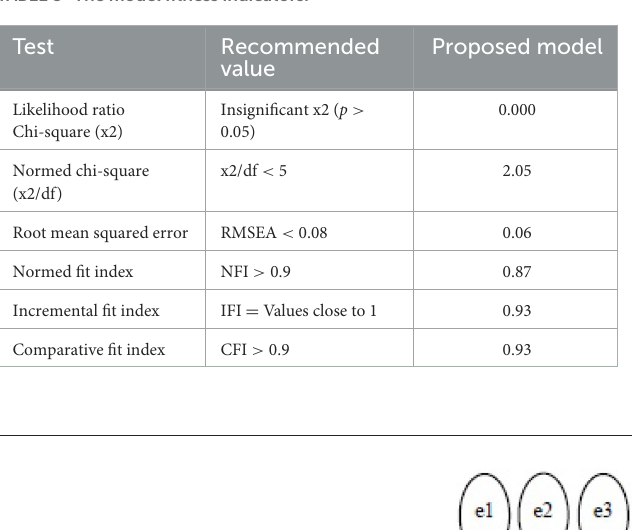
TABLE 3 The model fitness indicators.